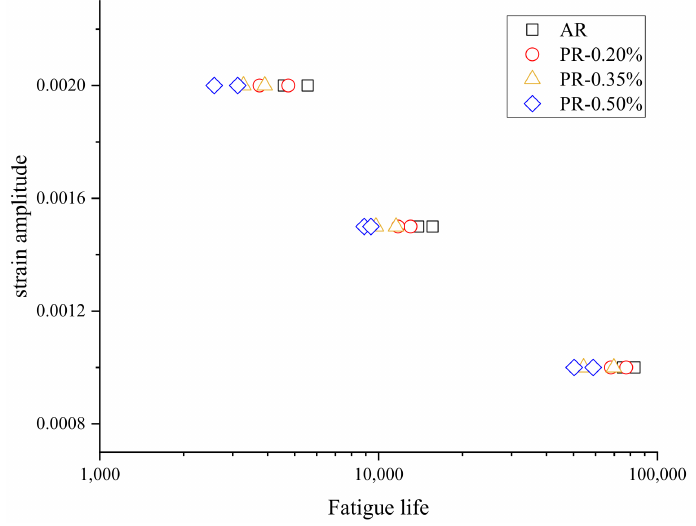
Figure 7. Strain amplitude fatigue life diagram.